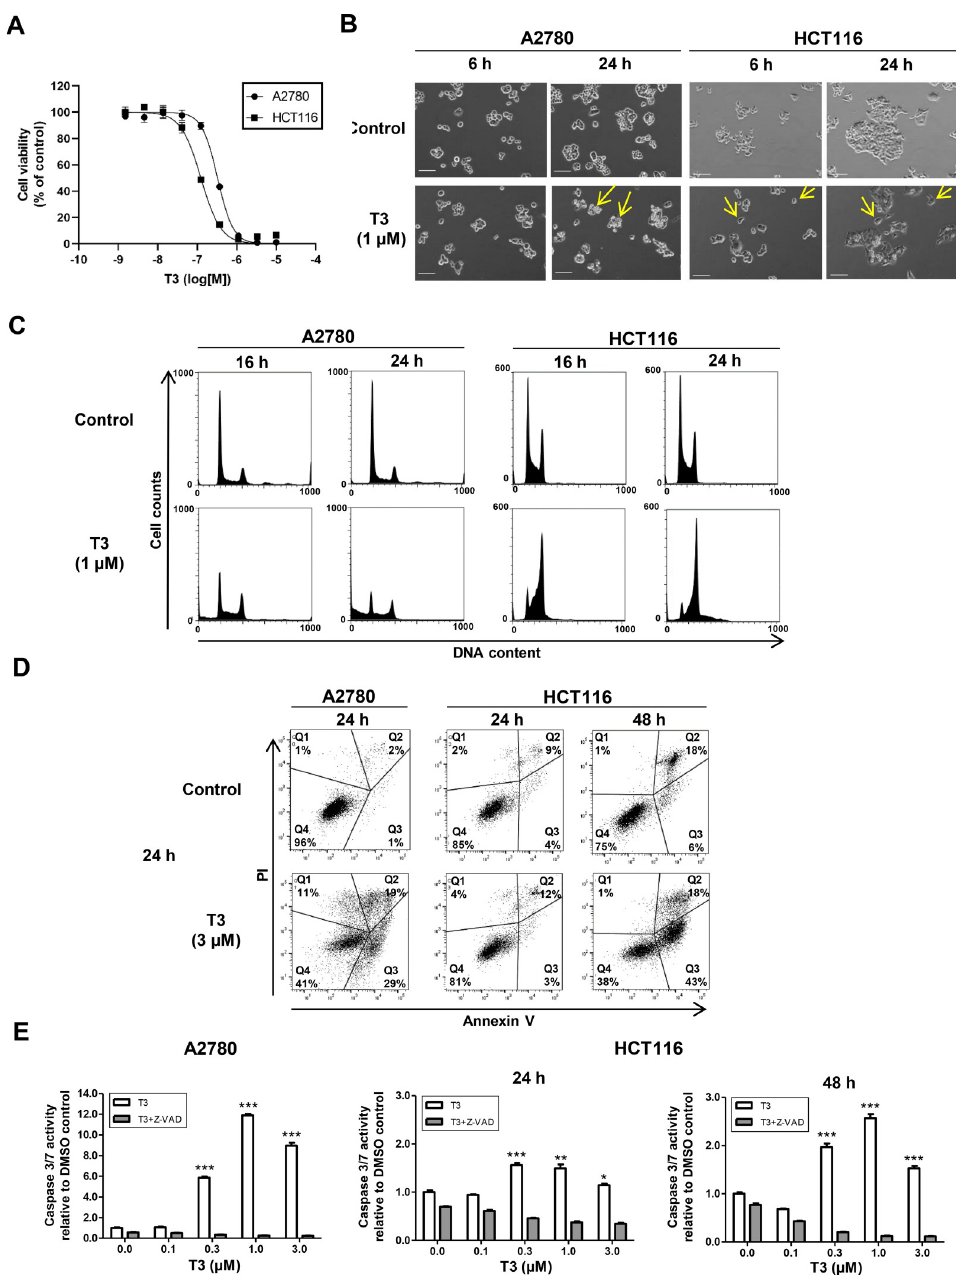
Fig 1. T3 inhibits growth of HCT116 and A2780 cells via different mechanisms. (A) Viabilities of A2780 and HCT116 cells normalized to the DMSO control after 72 h of T3 treatment. The x axis shows the compound concentration (logM). The y axis shows the percent inhibition of adenosine triphosphate contents, as compared to the DMSO control. Data are presented as the mean ± standard deviation (SD) of three independent experiments. (B) Time- lapse microscopic images of A2780 and HCT116 cells treated with DMSO or 1 μ M T3 for 6 or 24 h. The yellow arrowheads show shrunken cells in A2780 and enlarged cytoplasm in HCT116 cells after treatment with T3 for 6 h or 24 h. Scale bar = 100 μ m. (C) Flow cytometric analysis of the cell cycle distribution of HCT116 and A2780 cells treated with DMSO or 1 μ M T3 for 16 and 24 h. Data are representative of two independent experiments. (D) Flow cytometric analysis of apoptosis of A2780 and HCT116 cells stained with Annexin V/PI. Cells were incubated with T3 for 24 h (A2780 and HCT116 cells) or 48 h (HCT116 cells). Apoptosis was analysed by Annexin V/PI staining and flow cytometry. The percentage of cells within each quadrant are indicated. Q1: Annexin V (-)/PI (+), Q2: Annexin V (+)/PI (+), Q3: Annexin V (+)/PI (-) and Q4: Annexin V (-)/PI (-). Data are representative of two independent experiments. (E) Caspase 3/7 activity was measured in the presence or absence of Z-VAD-FMK and is presented as the fold change, as